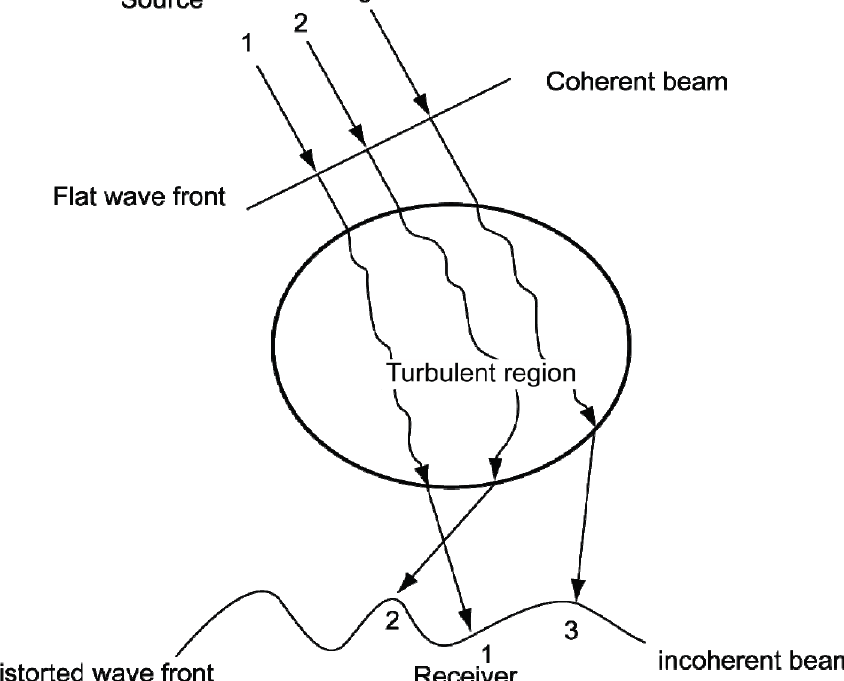
Figure 7. Wave propagation in a random medium like turbulence. The spectral and directional broadening of sound applies to waves in random media, including in the case of the shear layer (Figures 5 and 6) scattering by the randomly irregular convected interface and refraction by the entrained turbulence. The process is illustrated (Figure 7) in the latter case [296] of turbulence: (i) consider a coherent beam of parallel sound waves with the same frequency and a plane wavefront; (ii) since the velocity field of turbulence is random there are random Doppler shifts and also random convection of sound; (iii) thus the coherent beam emerges after crossing the turbulent region as an incoherent bundle of waves with different frequencies and a distorted wavefront; (iv) the acoustic variables like the pressure are correlated in space and time by the correlation of the turbulent velocity, or turbulence spectrum; (v) this specifies the acoustic power as a function of frequency and direction, that is the spectral directivity (Figure 6); (vi) the frequency spectrum and the directivity or range of directions of propagation will become broader the greater the distance of propagation and the stronger the turbulence intensity (Figure